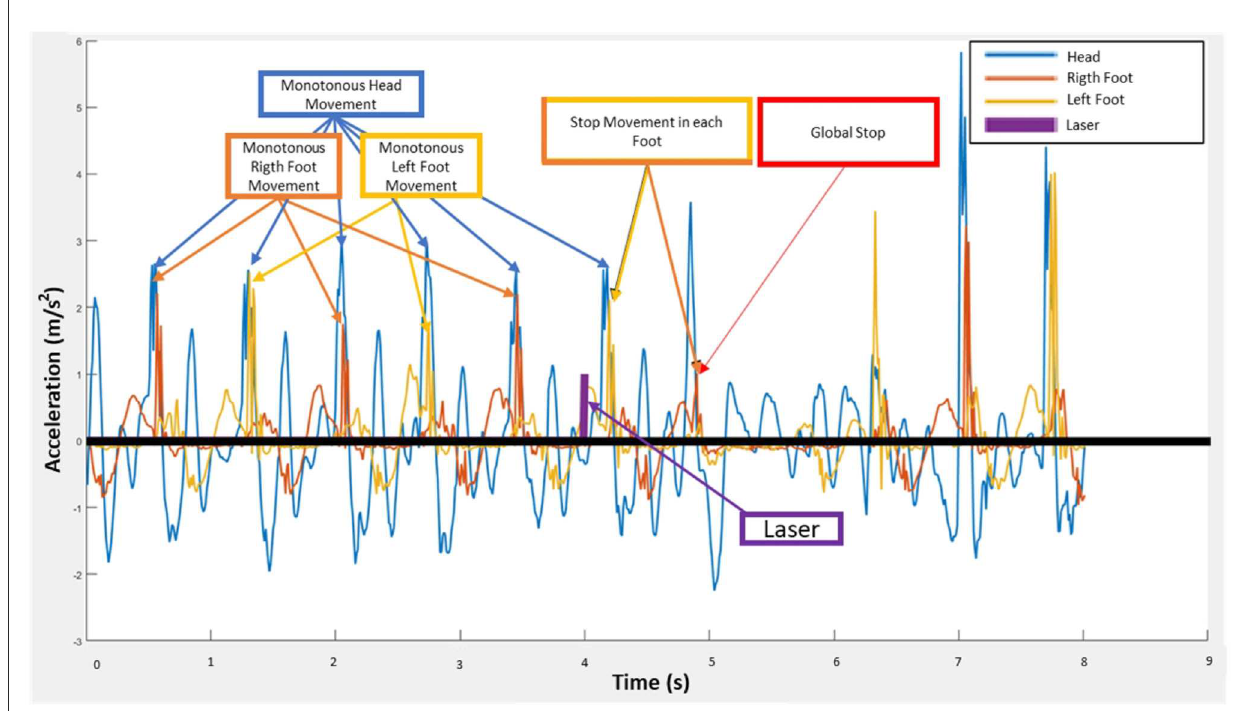
FIGURE2 IMU stop detection based on the analysis of the right and left foot: Trial 2, Repetition 1, Subject SE.1.